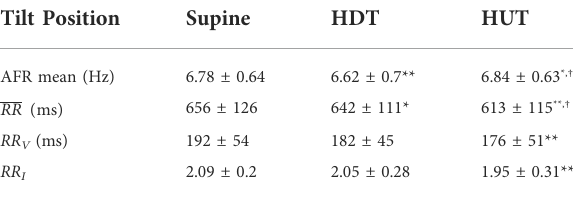
TABLE 3 Mean ± std of AFR and RR series characteristics of the 24 patients in the study population for each tilt